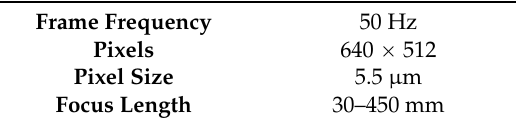
Figure 5. FOG FFT analysis ( a ) FFT of the original signal; ( b ) FFT of the integration signal. Table 1. CCD parameters. The CCD characteristic in this system is shown in Table 1.